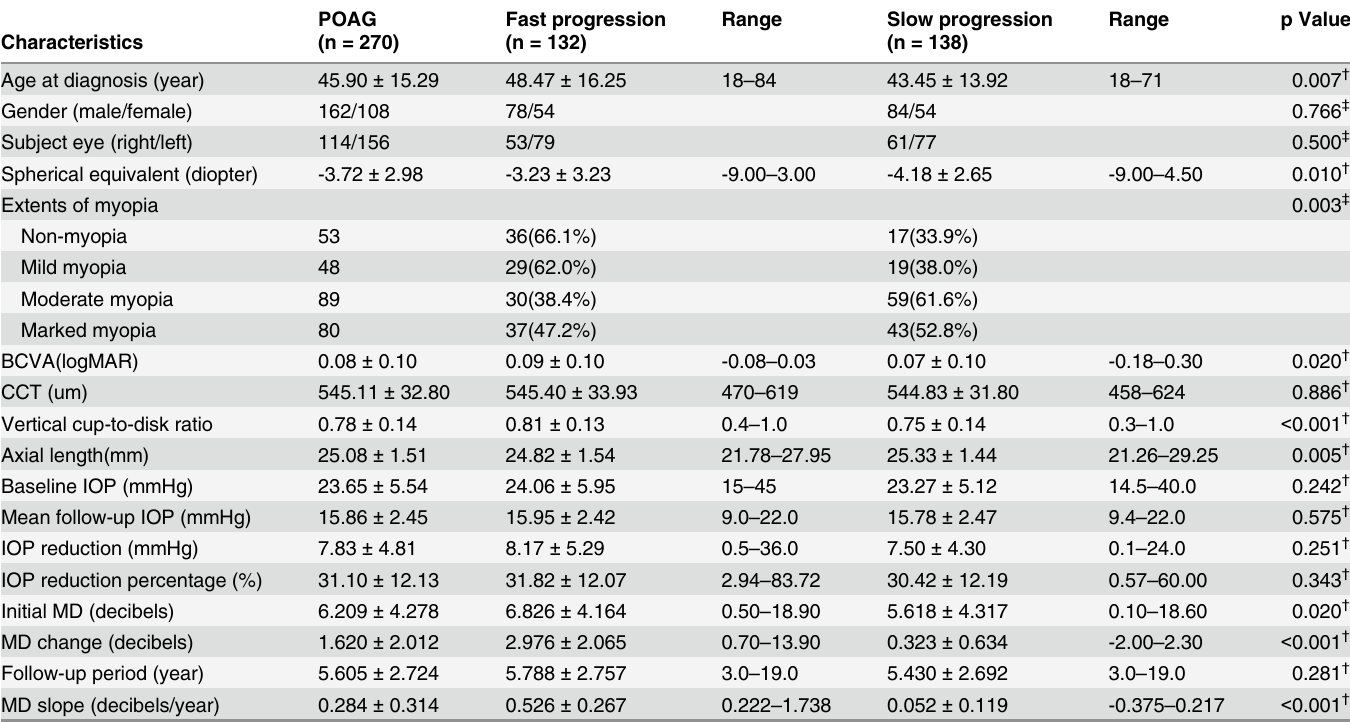
Table 1. Characteristics of patients with primary open-angle glaucoma. Fast/Slow progression was classified at the MD slope of 0.22